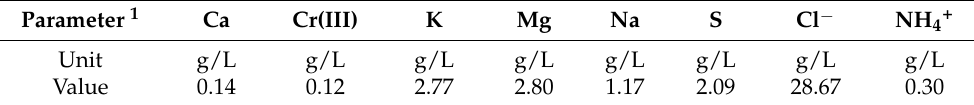
Table 2. Chemical composition of the concentrate obtained by processing of a real effluent from TAMEG-Rouiba Tannery with an RO SW30 membrane [12], at pH 3.6 and T = 20 ◦ C. Parameter 1 Ca